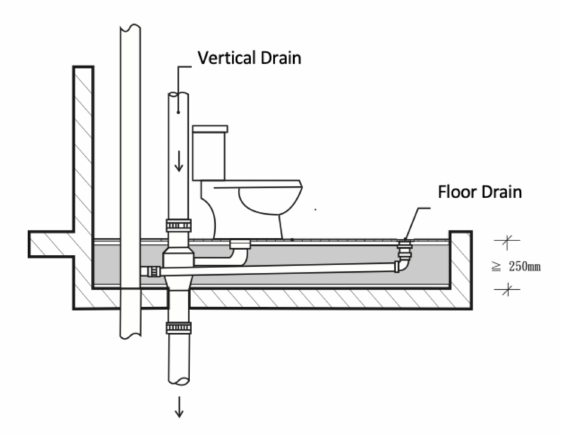
Figure 2. Schematic definition of the descended floor piping